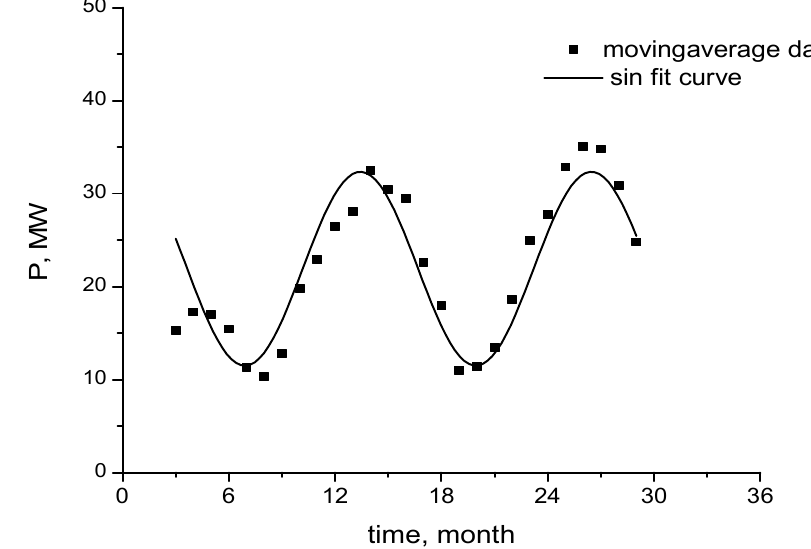
Figure 14. Correlation between statistical model and data smoothed using moving average method.